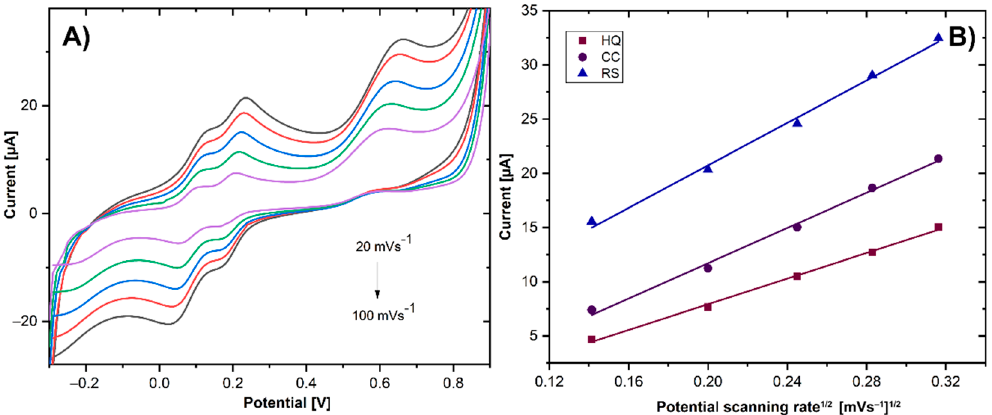
Figure 8. ( A ) Cyclic voltammetry of GCE/ErGO-cMWCNT/AuNPs in presence of HQ, CC, and RS at pH 7.0 with different scan rates. ( B ) Plots of effects of anodic peak potential vs. v 1/2 .